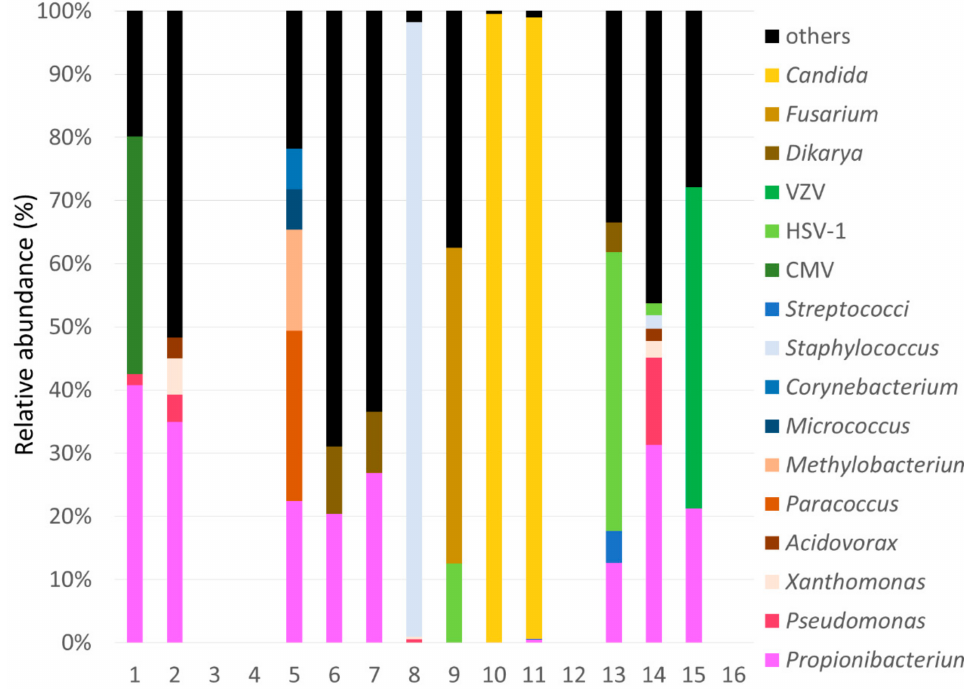
Figure 3. Rate of microbial reads in each case.